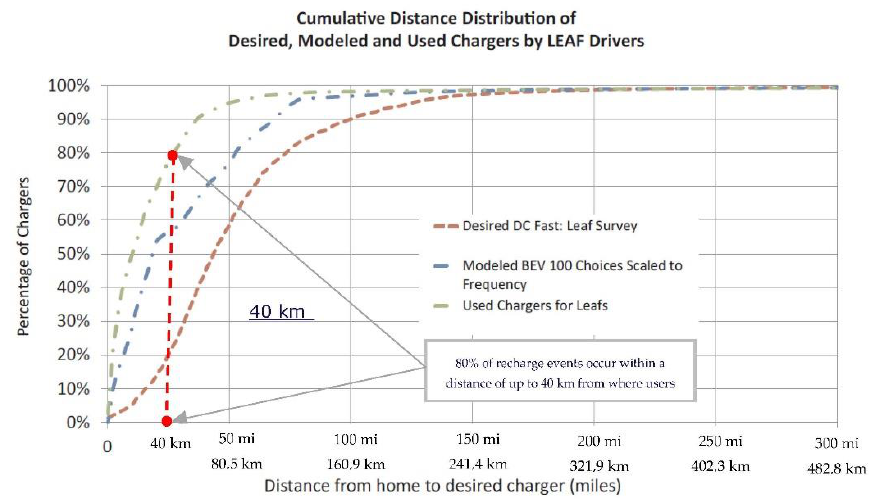
Figure 12. Distances from users to charging stations—Adapted from [6], data from [28] shows that DC fast charging occurs mainly close to the home of EV owners.